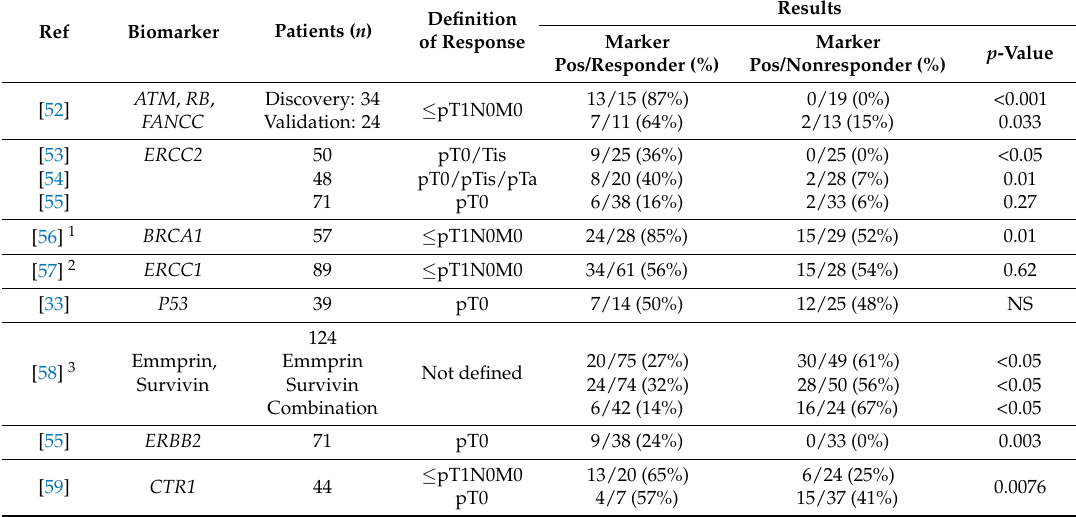
Table 1. Summary of association of biomarkers with response to NAC based on the published studies.